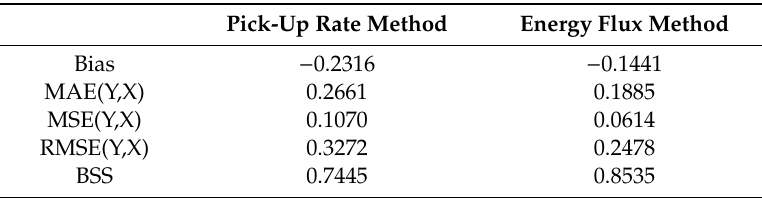
Table 5. Obtained statistical parameters in the area of interest for both the pick-up rate simulation and the energy-flux simulation-Dataset of a